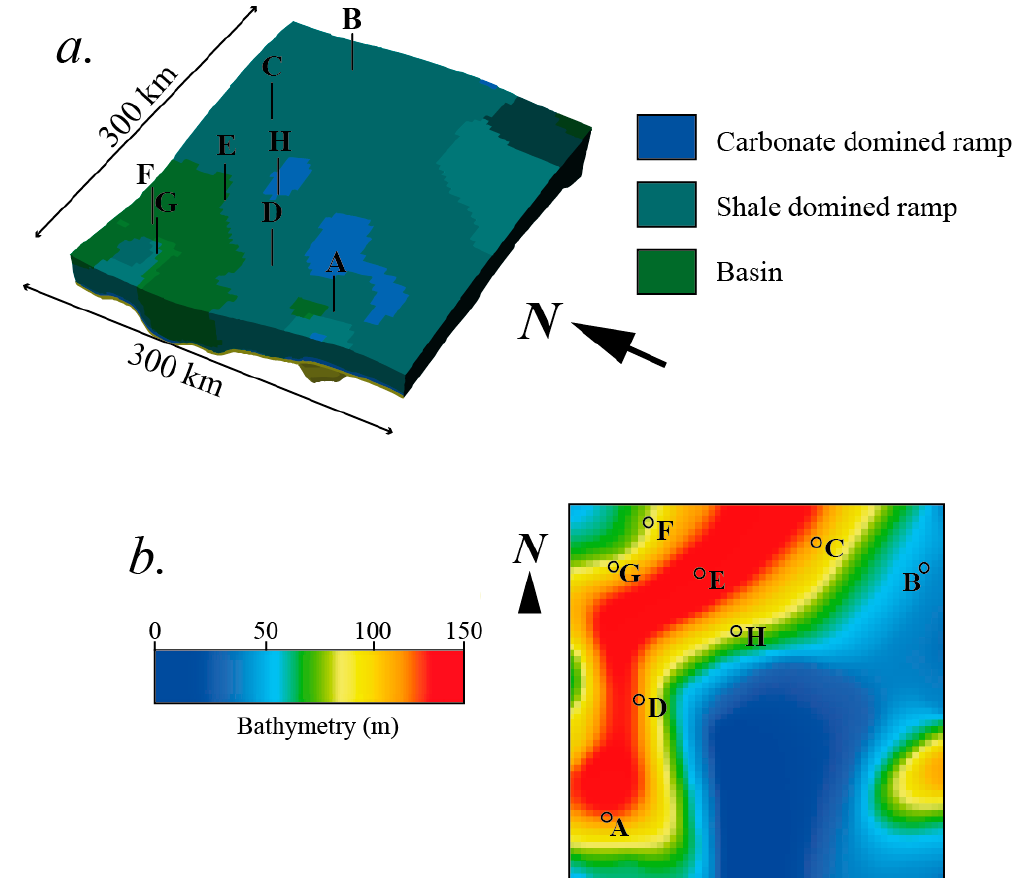
Figure 7. ( a ) 3D block with the facies distribution for Lower-Middle Toarcian (181.7 to 179.7 Ma) for the modelled area (vertical exaggeration = 200); ( b ) Bathymetry map at 181.7 Ma (start of the simulation). The deepest part of the basin developed in the western and northern part of the actual Bourgogne region that is characterized by a shallow water area (<150 m of bathymetry). A, B, C, D, E, F and G are the calibration wells.